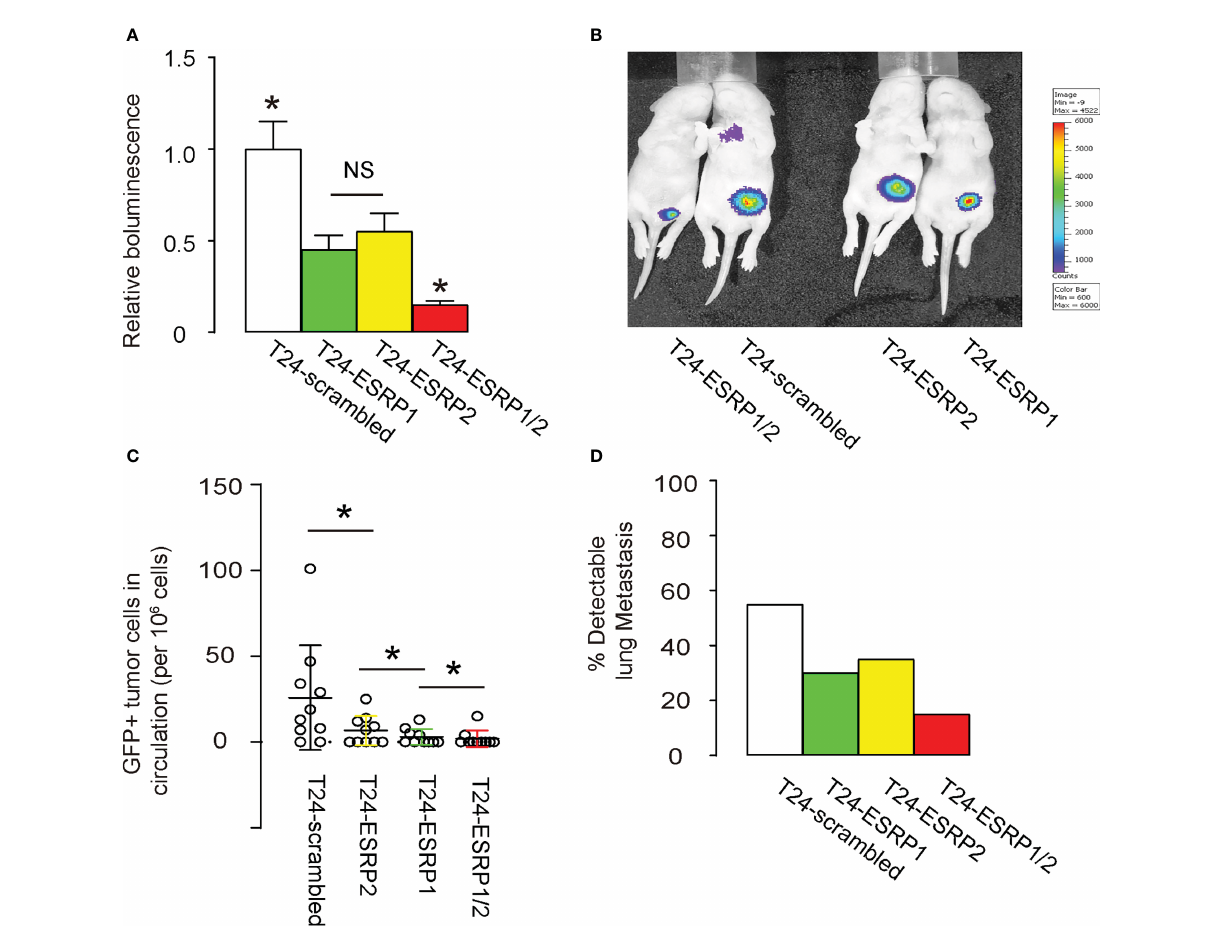
FIGURE 5 ESRP1/2 reduces growth and lung metastasis of xeno-transplanted BC cells in nude mice. (A-D) Equal number of ESRP1, ESRP2, combined ESRP1/2 and scrambled transfected T24 cells were subcutaneously transplanted into the location above the lower abdomen of the nude mice. On month after transplantation, tumor formation in 5 mice was assessed by bioluminescence, shown by quanti fi cation (A) , and by representative images (B) . (C) Quanti fi cation of GFP+ tumor cells in mouse circulation at 1 month after transplantation. (D) The frequency for forming metastatic lung tumors in 20 mice per group. *p<0.05. NS, non-signi fi